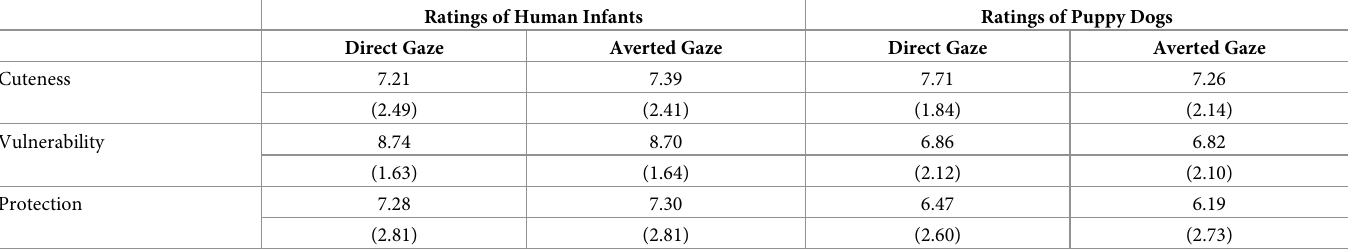
Table 4. Experiment 4: Mean ratings (with standard deviations in parentheses) of human infants and puppy dogs, as a function of whether their eye gaze was direct or